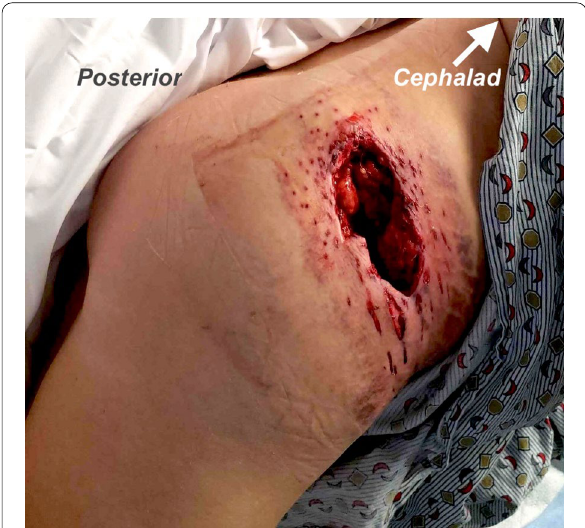
Fig. 2 Image of the patient’s wound on the day of